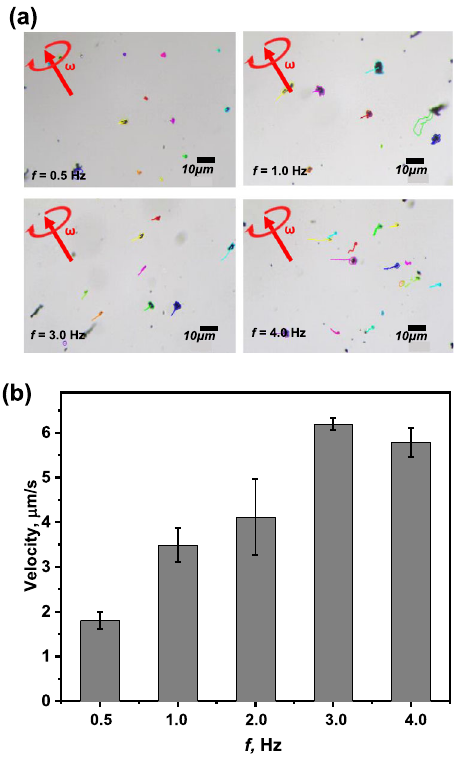
Fig. 3 Tracking of TM nanorobots. ( a ) optical images highlight the magnetic work function of the TM nanorobots using the transversal rotating magnetic frequency range of 0.5 – 4Hz and ( b ) quantitative velocity of the TM nanorobots as a function of rotating magnetic- fi eld frequency. All velocity data are summed for 30 TM nanorobots under the same propulsion conditions. The error bars represent standard deviation based on three measurements.